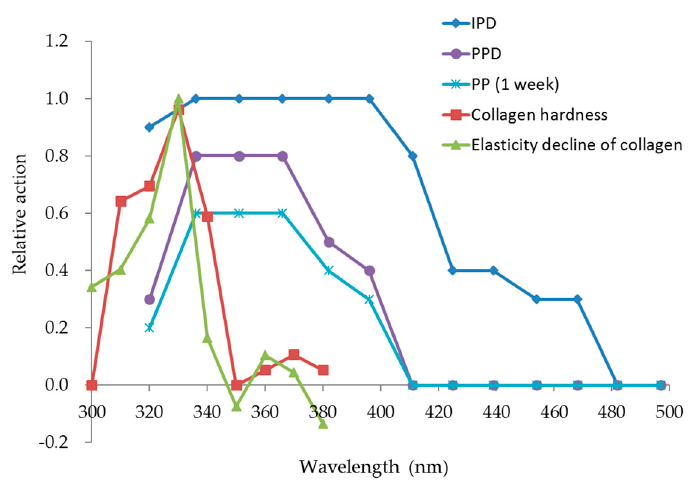
Figure 9. Comparison of the spectrum of UV radiation that damages collagen and the spectra of IPD, 24 h after irradiation of PP (PPD; persistent pigment darkening), PP (1 week after irradiation) [17].